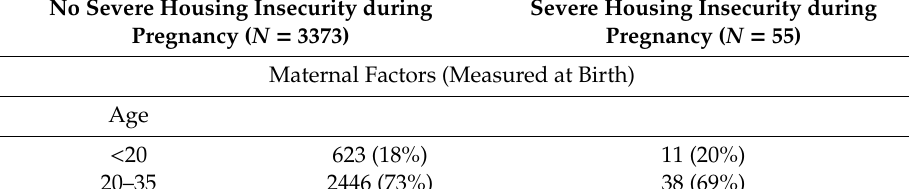
Figure 2. Flow diagram showing specification of study populations sourced from the Fragile Families and Child Wellbeing Study, 1998–2000.